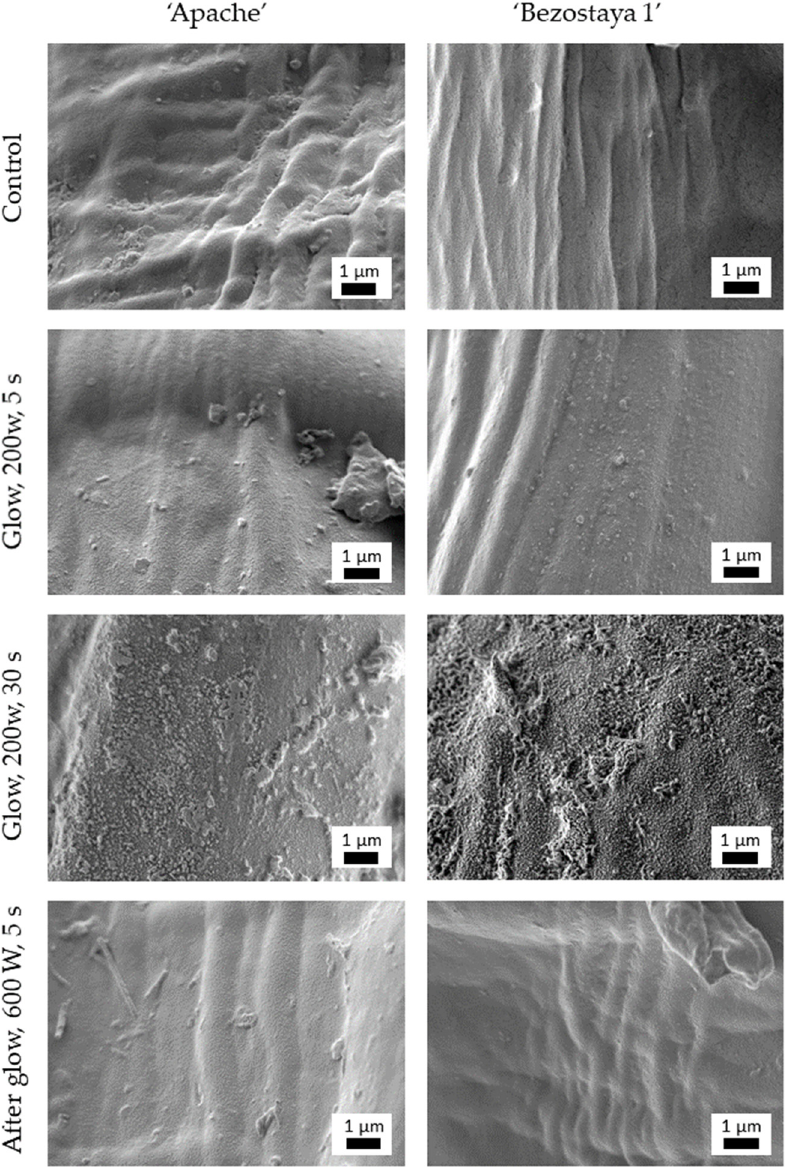
Figure 1. SEM images of the wheat seed coat of the Apache and Bezostaya 1 varieties of non-treated seeds, seeds treated with the glow regime (direct plasma) for 5 and 30 s at a power of 200 W, and seeds treated with the afterglow regime (indirect plasma) for 5 s and power of 600 W.